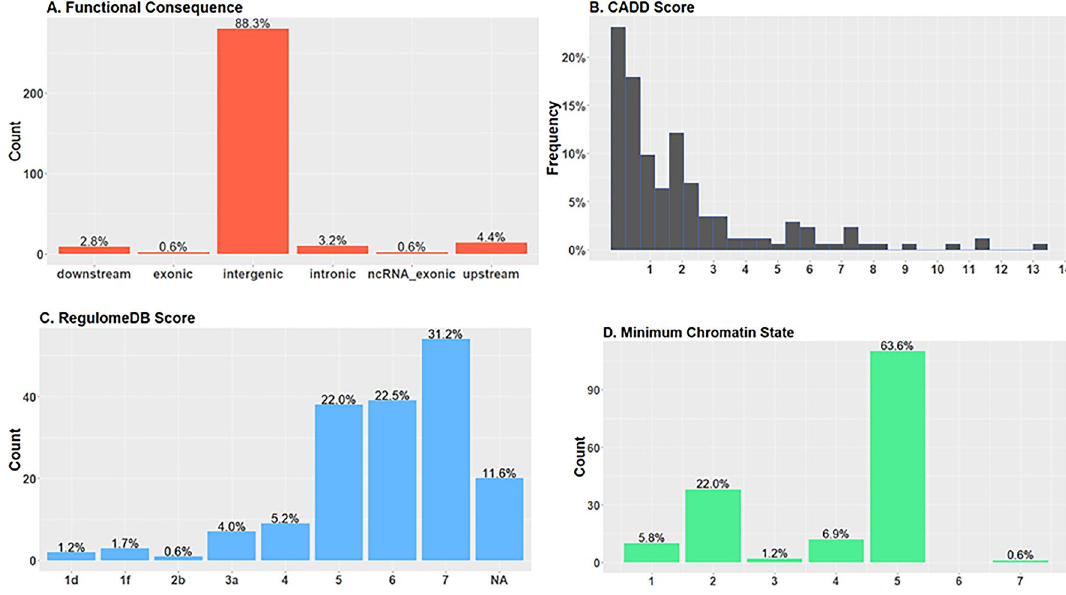
Figure 4. Functional annotation of 173 single nucleotide polymorphisms (SNPs) found to be in linkage disequilbrium (r 2 > = 0.6) with the four independent SNPs showing genome-wide significant association with podoconiosis. ( A ) Distribution of functional consequences of SNPs in genomic risk loci ( B ) Distribution of combined annotation dependent depletion (CADD) score for SNPs in genomic risk loci. A score greater than 12.37 indicates deleterious SNPs. ( C ) Distribution of RegulomeDB score for SNPs in genomic risk loci. A score less than 4 indicates regulatory function. ( D ) Minimum chromatin state for 127 tissue/cell types for SNPs